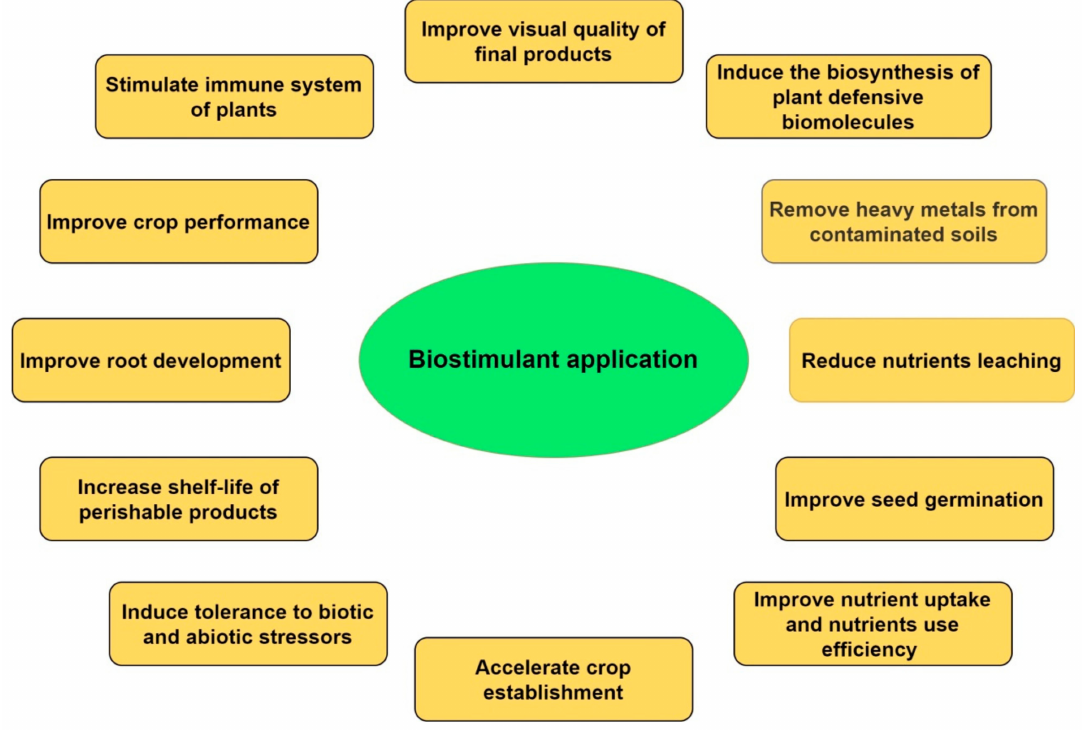
Figure 1. The most important biostimulant effects on